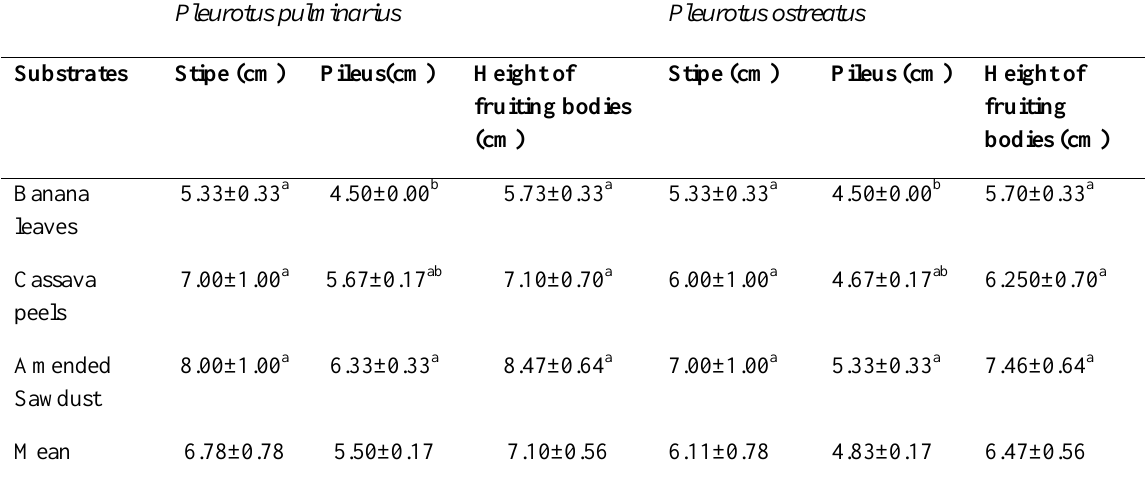
Table 2: Effects of substrates on the morphology of Pleurotus pulminarius and Pleurotus